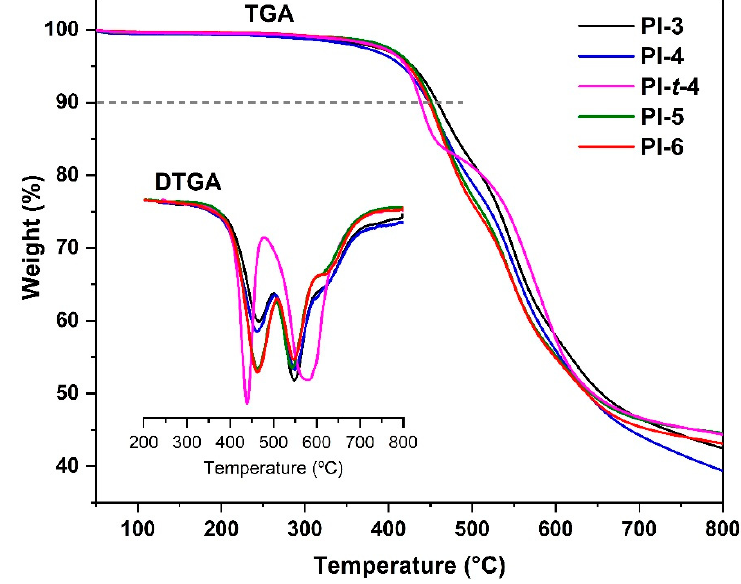
Figure 4. TGA and DTGA curves of poly(imide)s.